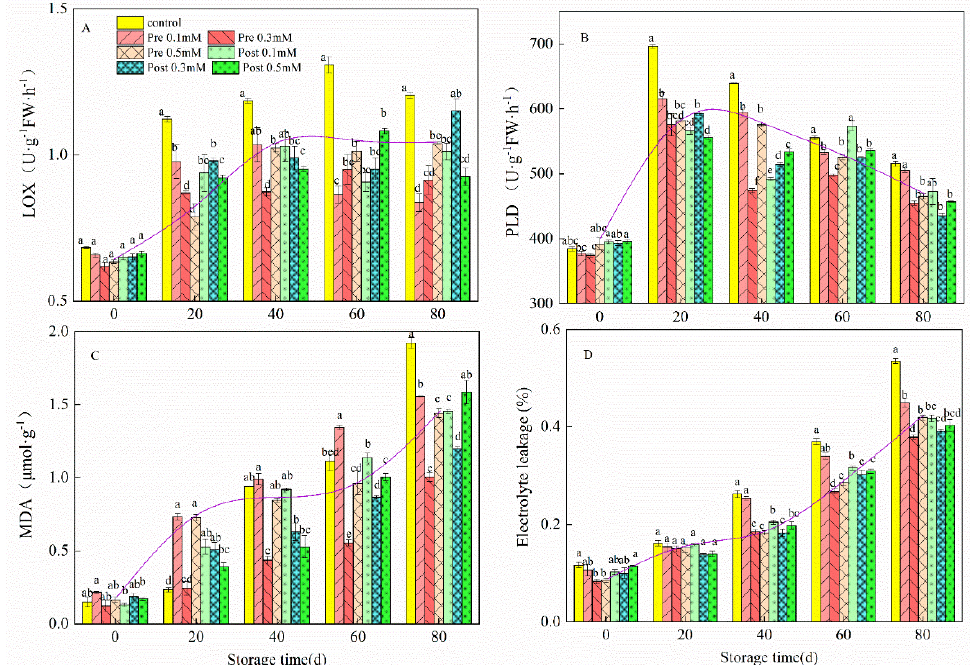
Figure 6. Effect of pre-harvest (Pre) and post-harvest (Post) methyl jasmonate treatments on LOX ( A ), PLD ( B ), MDA ( C ) and electrolyte leakage ( D ) in lemon in storage at 7–10 ◦ C. Data are the mean ± SE of three replicates of five fruit. Different lowercase letters show significant differences among treatments for each sampling date at p < 0.05 level.